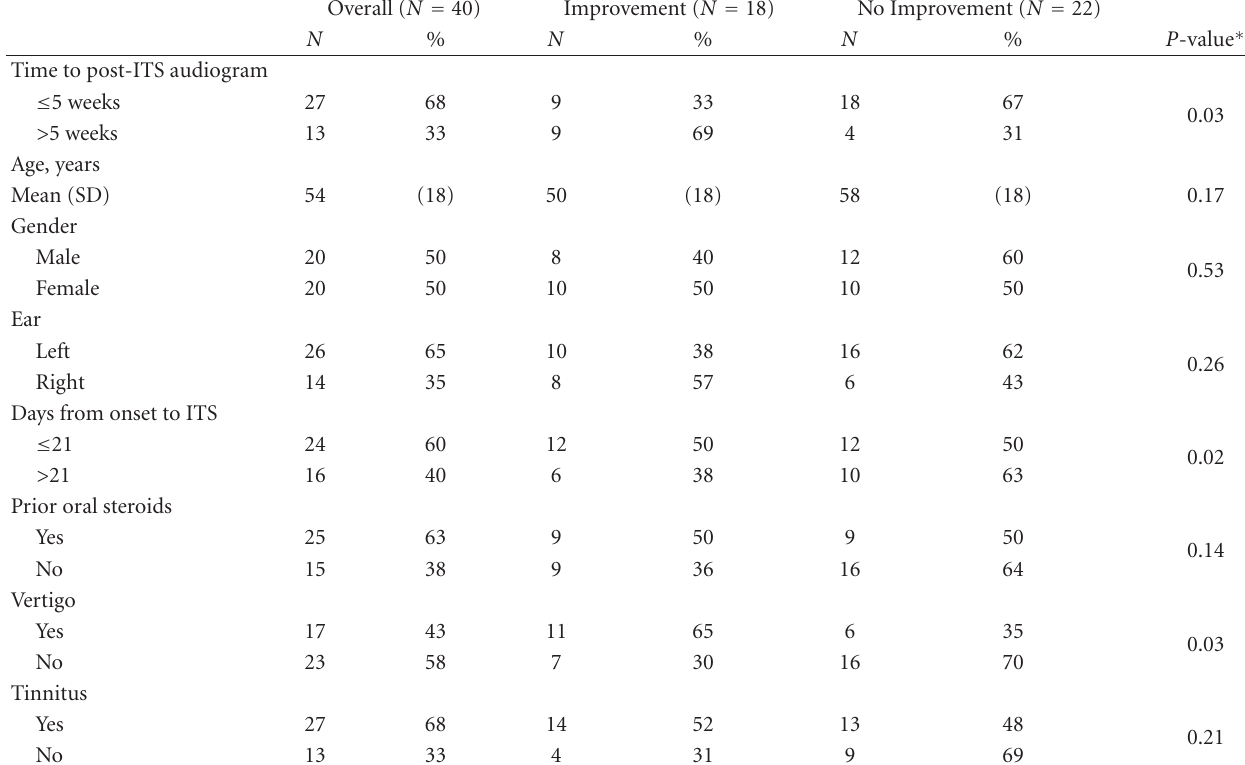
Table 4: Patient variables and associated response to treatment.